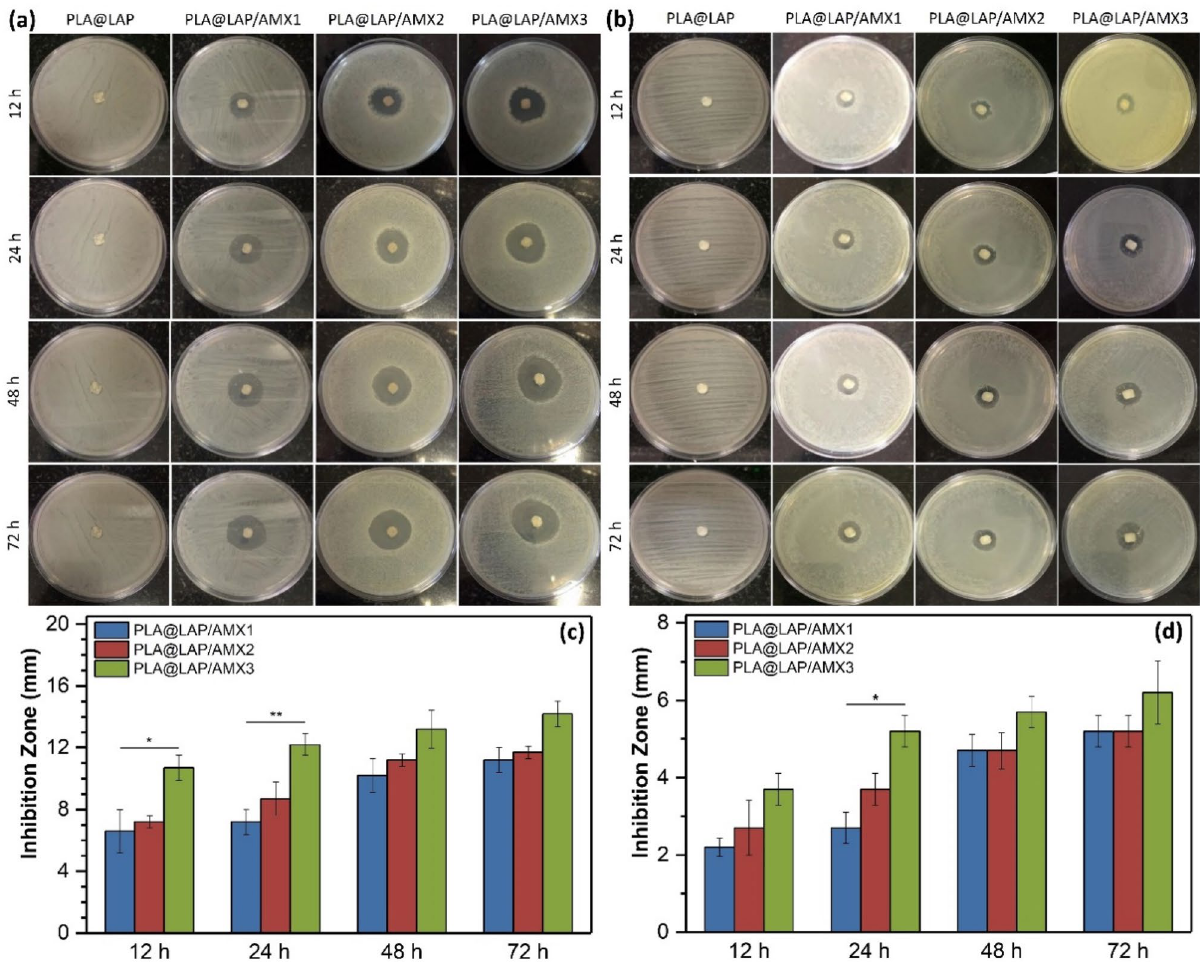
Figure 5. Antibacterial activity of scaffolds against S. aureus ( a ) and E. coli ( b ). Measured inhibition zone of scaffolds against S. aureus ( c ) and E. coli ( d ) (n = 3, * p < 0.05, ** p <